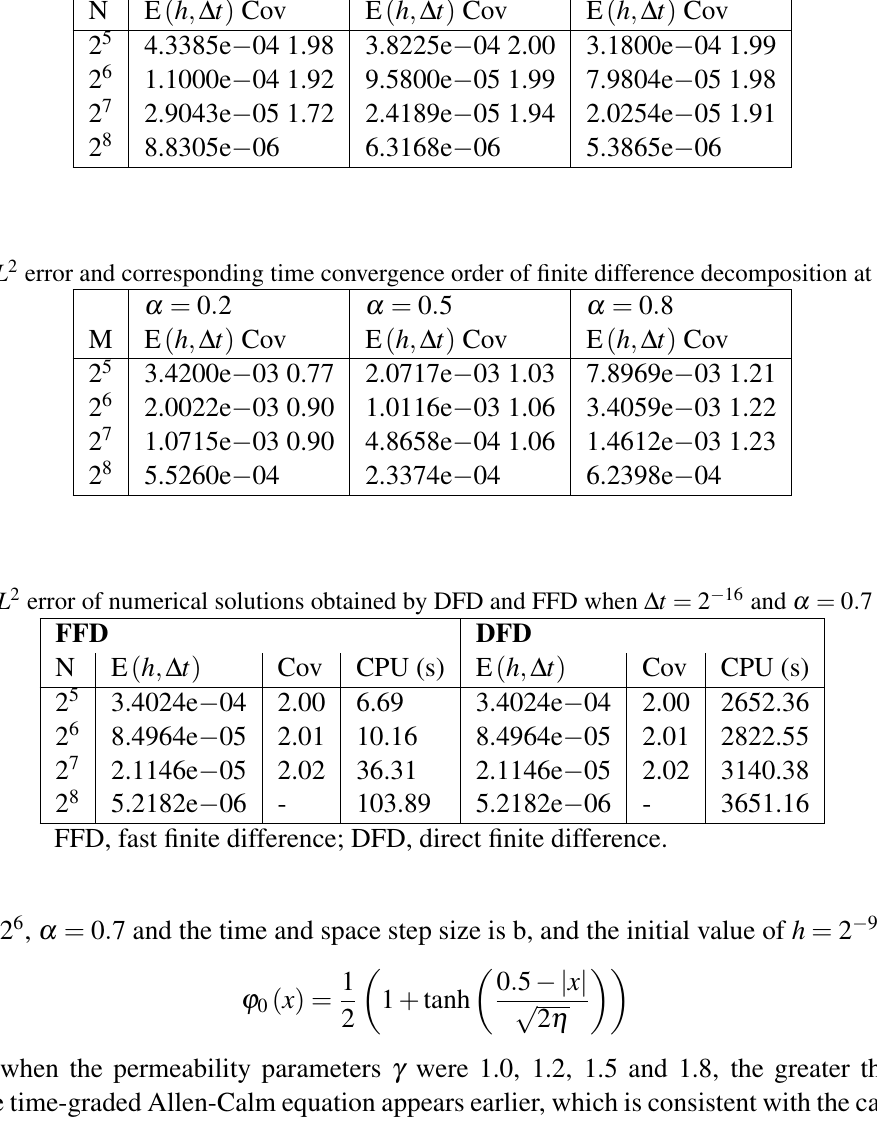
Table 1 L 2 error and corresponding spatial convergence order of finite difference decomposition at ∆ t = 2 − 16 α = 0 . 2 α = 0 . 5 α = 0 . 8